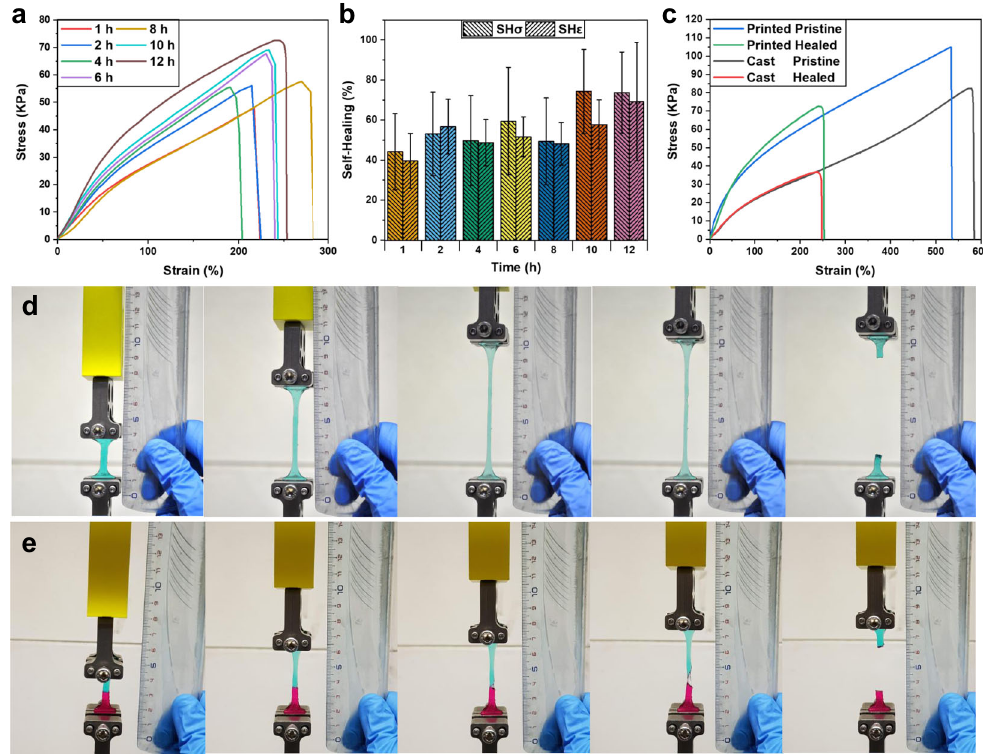
Fig. 4 Uniaxial tensile test of specimens made with PVA 0.8 formulation. a Stress – strain curves of the self-healed hydrogels for increasing healing time and b comparison of the healing ef fi ciencies estimated from tensile strength at break (SH σ ) and elongation at break (SH ε ). Error bars represent standard deviation, n = 5 independent replicates. c Stress – strain curves of printed pristine and healed samples compared with the same curves obtained from cast pristine, and healed samples. d , e Elongation and rupture behavior during the test of d pristine sample and e 12 h healed sample